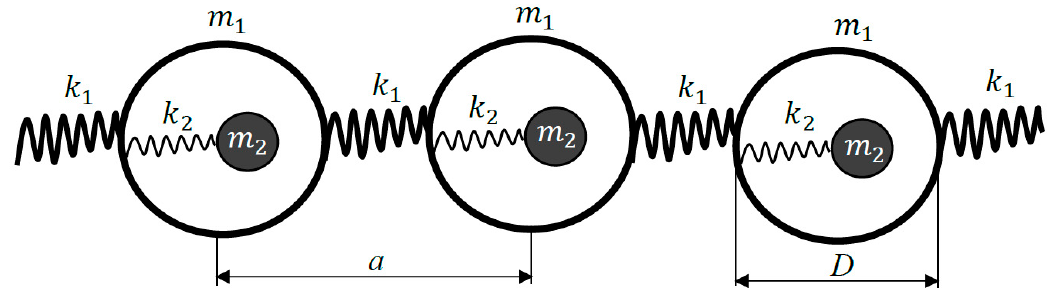
Figure 2. The mechanical scheme of the one-dimensional lattice is depicted.